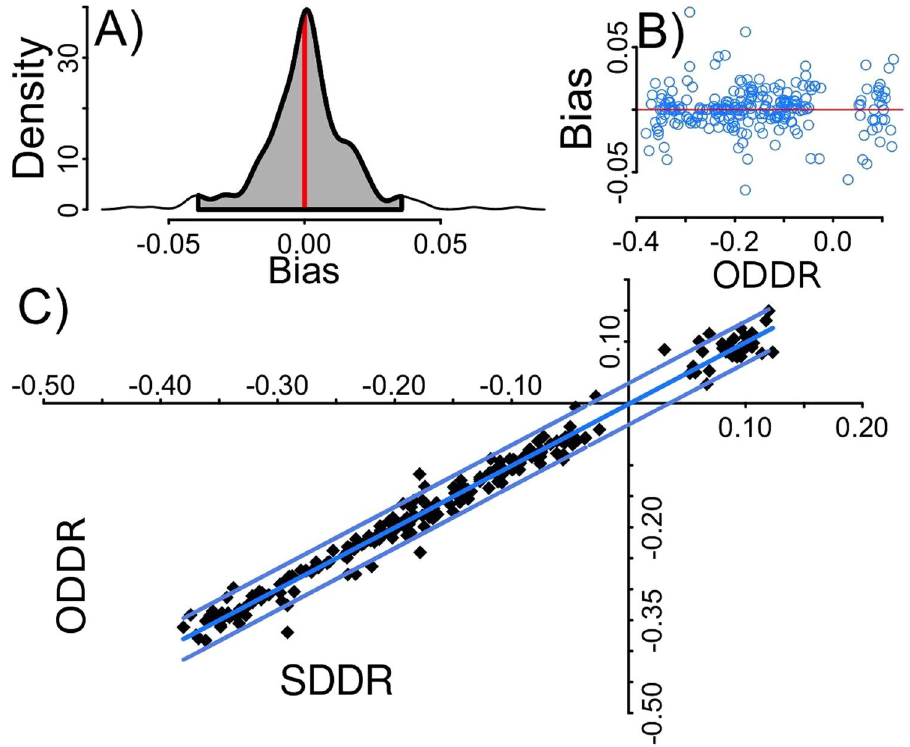
Figure 4. Validation of the method. ( A ) The density distribution of the calculated bias between the daily averaged drift rate from summarized data (SDDR) and the observed daily averaged drift rate (ODDR) for the three seals. Grey shadowed area covers the 95% confidence interval, and vertical red line is drawn at the median. ( B ) The calculated bias versus the ODDR, evidencing a lack of any trend (horizontal red line set at Y = 0). ( C ) The positive linear relationship between the ODDR and the SDDR and the 95% confidence interval